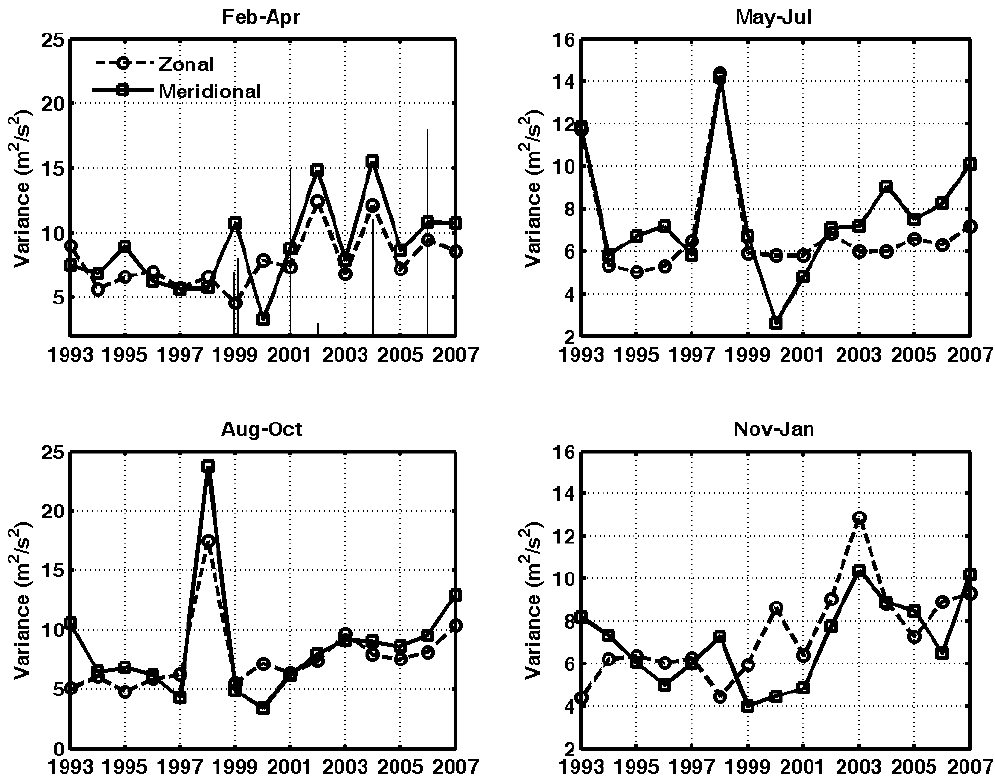
Fig. 4. Monthly mean gravity wave variances in zonal and meridional winds for 1993–2007 and for spring equinox (left top), summer (right top), fall equinox (left bottom) and winter (right bottom) months. The vertical bars in the top left panel denote the duration (days) of stratospheric